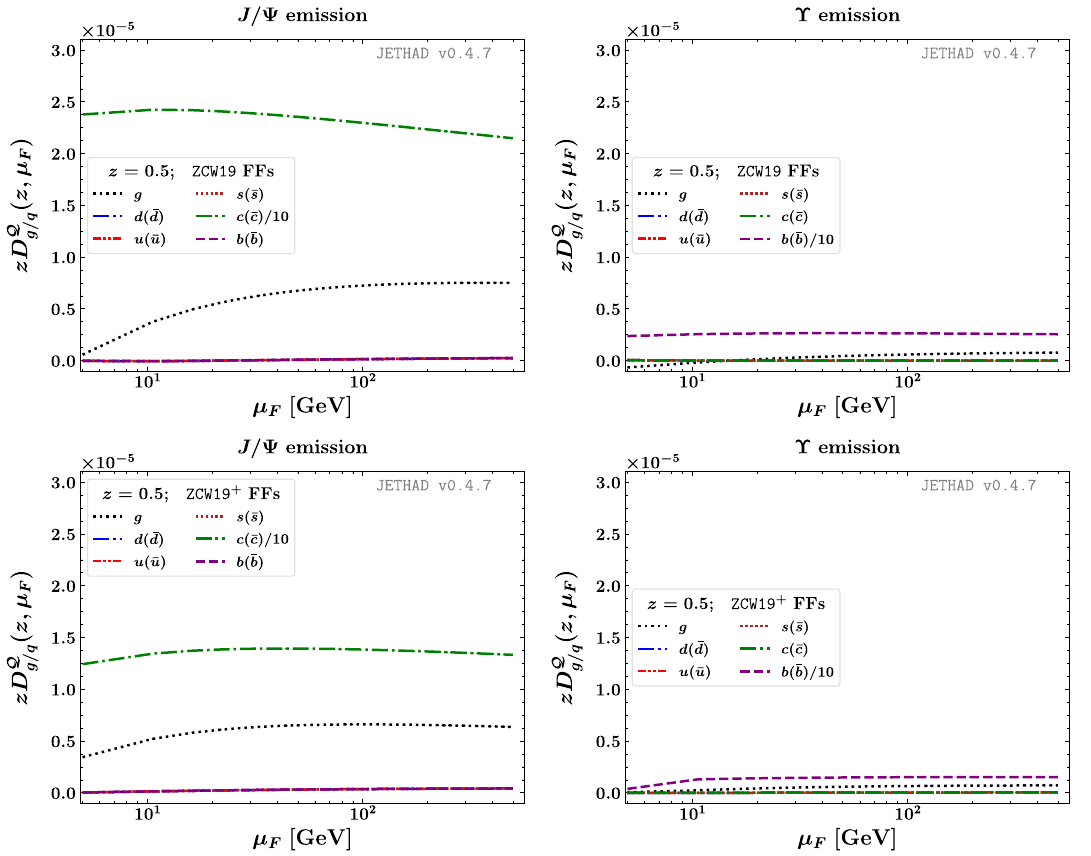
Fig. 3 Energy-scale dependence of ZCW19 (upper) and ZCW19 + (lower) NLO FFs depicting J /ψ (left) and ϒ (right) emission, for z = 5 × 10 − 1